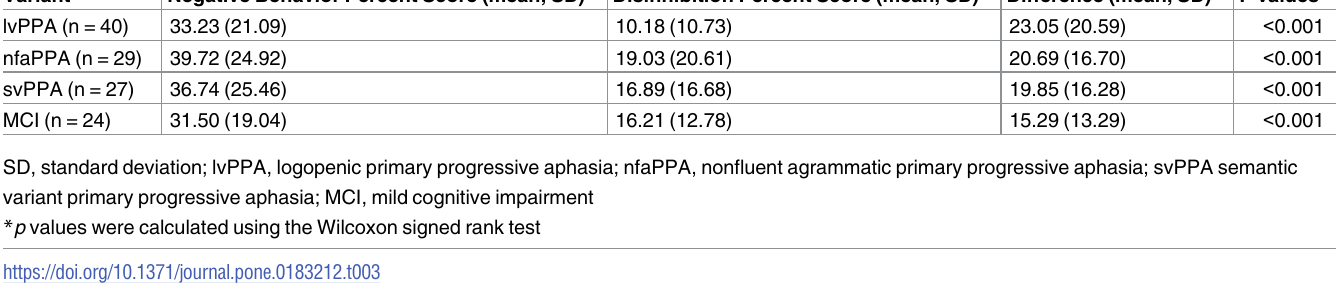
Table 3. Comparison of the difference between negative behavior and disinhibition scores in percent within PPA subtypes and MCI. Variant Negative Behavior Percent Score (mean,